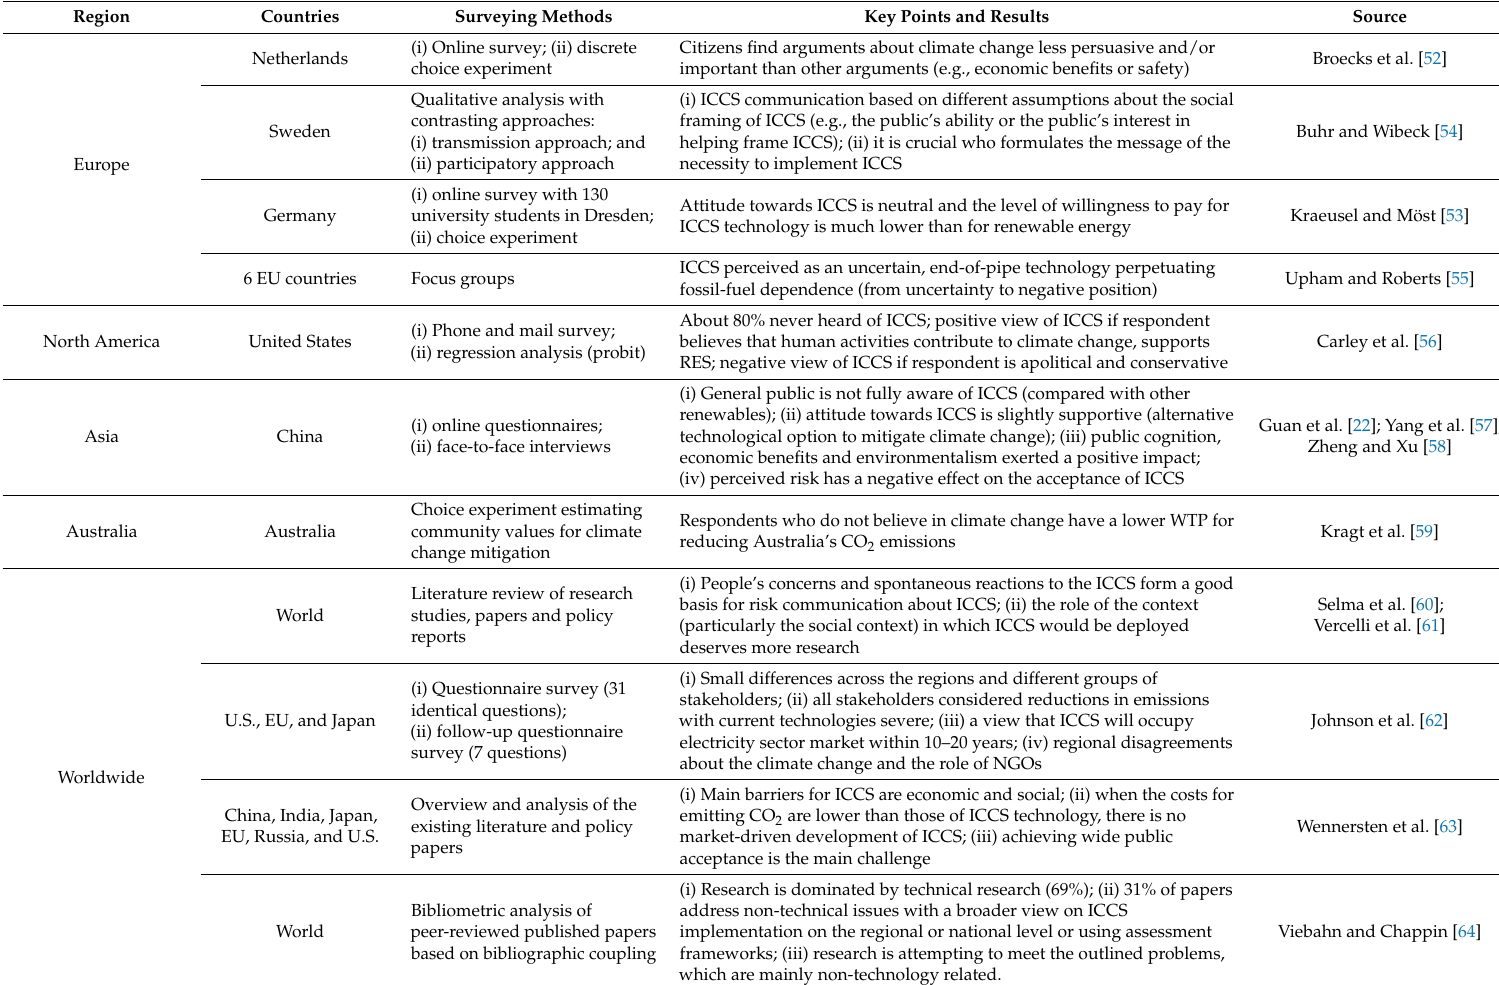
Table 1. Overview of relevant selected studies on consumer attitudes towards